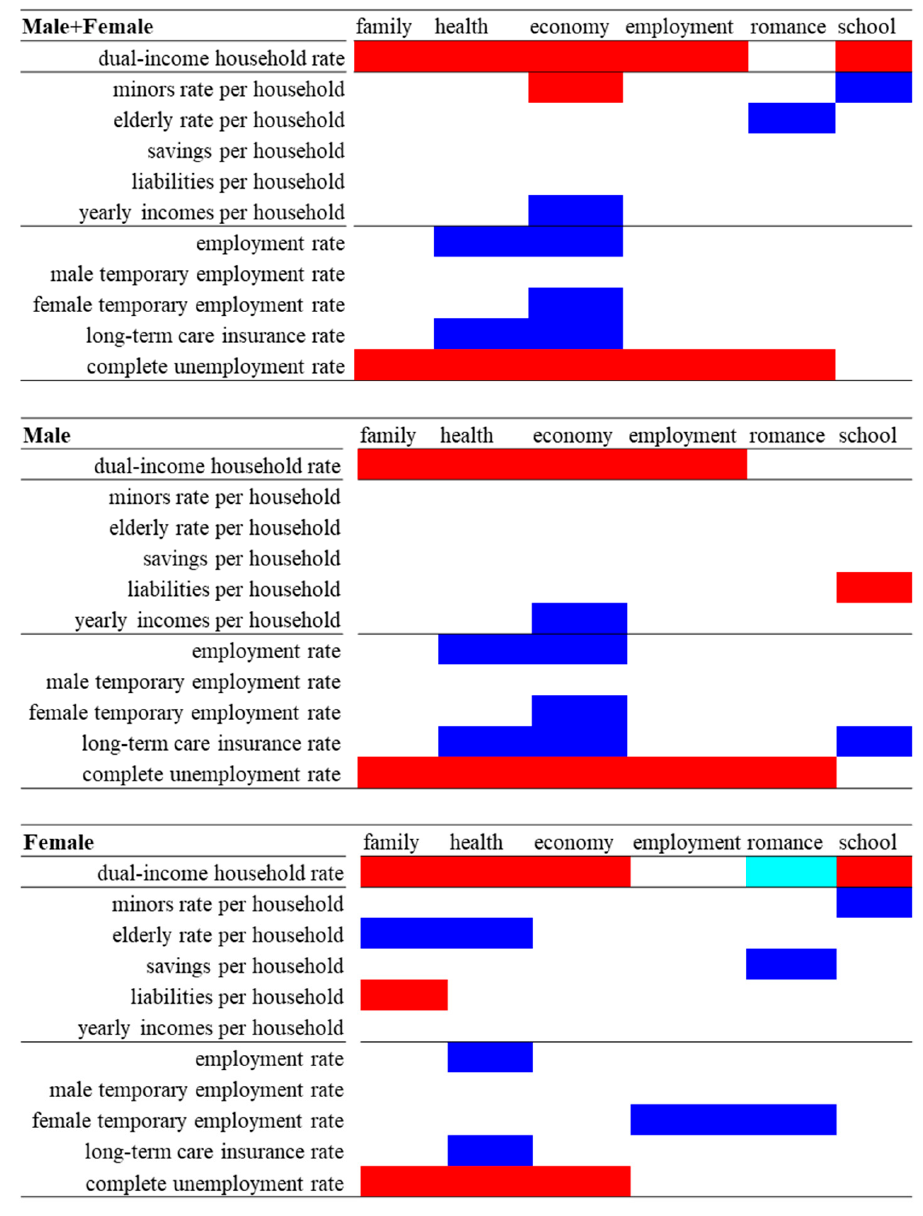
Figure 1. Summary of impacts of dual-income household rate, household structural and social/employment factors on suicide mortalities of Male + Female, Male and Female caused by family-, health-, economy-, employment-, romance- and school-related motives between 2009 and 2017. Blue and red columns indicate significant factors for decreasing and increasing suicide mortali- ties caused by each motive, respectively, in either Model_2. Light blue column indicates significant factors for decreasing suicide mortalities caused by each motive in Model_1, but not in